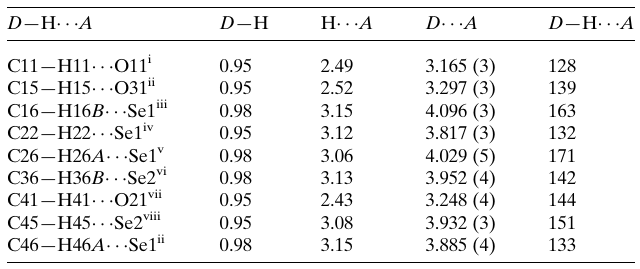
Table 2 Hydrogen-bond geometry (A˚ , (cid:5) ).